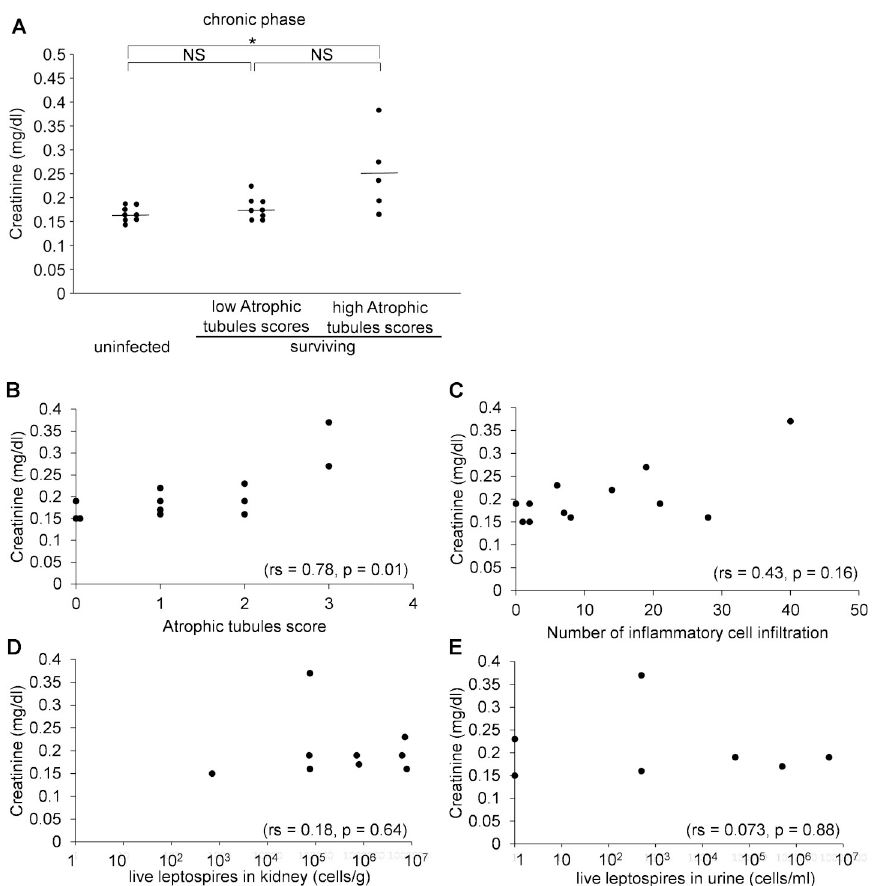
Fig 6. Serum creatinine levels of surviving hamsters in the chronic phase and uninfected hamsters. (A) After infection with L . interrogans serovar Manilae strain UP-MMC-SM, surviving hamsters were divided into two groups according to the atrophic tubules score. Serum creatinine levels were compared among 3 groups: the high atrophy tubules score group, the low atrophy tubules score group, and uninfected group (n = 5, 8, 8, respectively). The average value for each group is indicated by a bar. The Kruskal-Wallis were used to compare serum creatinine levels among the 3 groups ( p = 0.035). The significance level was p < 0.05. � p < 0.05 between groups. NS; not significant. (B-E) Spearman’s rank correlation coefficients for serum creatinine levels and each of the four variables (atrophic tubules score, number of inflammatory cell infiltration, and numbers of leptospires in the kidney and urine) are shown. The number of inflammatory cells infiltration was counted as the spots infiltrated by the inflammatory cells in the whole longitudinal section of the kidney under microscope. The numbers of leptospires in the kidney and urine were measured by the limiting dilution culture method. In surviving hamsters, the serum creatinine level was statistically correlated with the atrophic tubules score. The significance level was p < 0.05. The number of data varies depending on the factor because of the missing value. (B) Scatter plot of serum creatinine and atrophic tubules score (n = 12, rs = 0.78, p = 0.01). (C) Scatter plot of serum creatinine level and the number of spots with inflammatory cell infiltration (n = 12, rs = 0.43, p = 0.16). (D) Scatter plot of serum creatinine and the number of leptospires in the kidney (n = 9, rs = 0.18, p = 0.64). (E) Scatter plot of serum creatinine and urinary leptospires (n = 7, rs = 0.073, p =